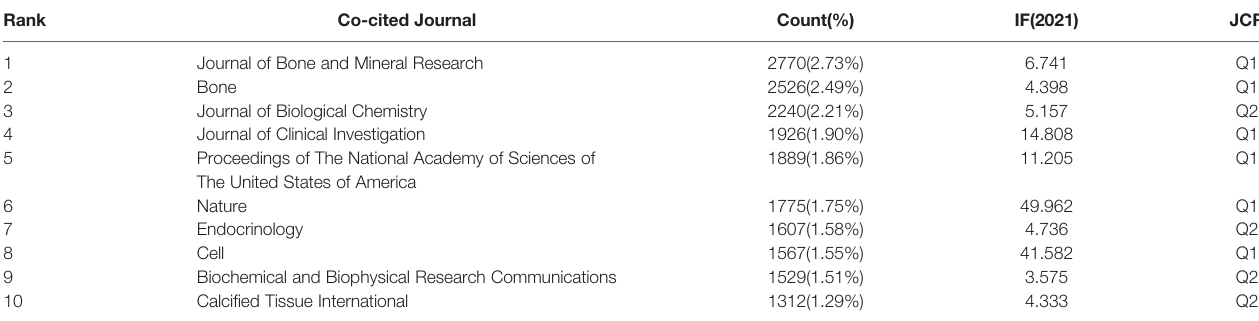
TABLE 2 | The top 10 co-cited journals of osteoblasts-osteoclasts in bone disease research.